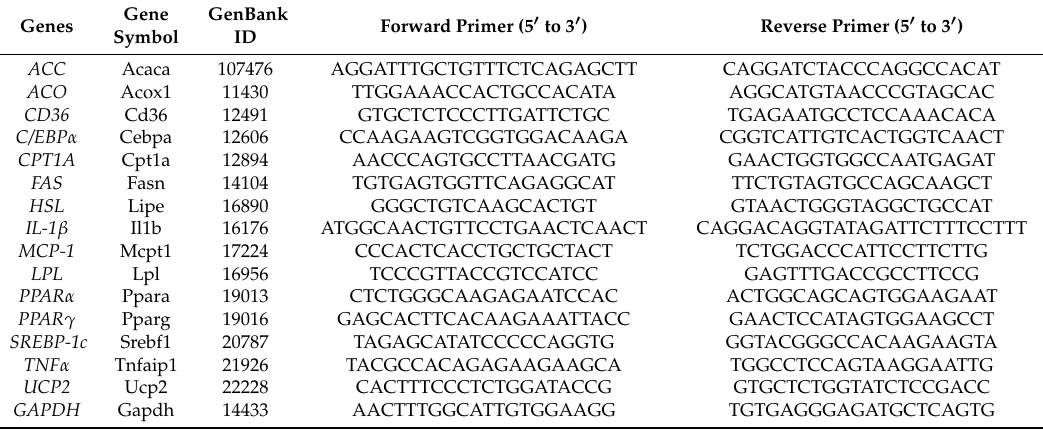
Table 4. Primer sequences used in real-time